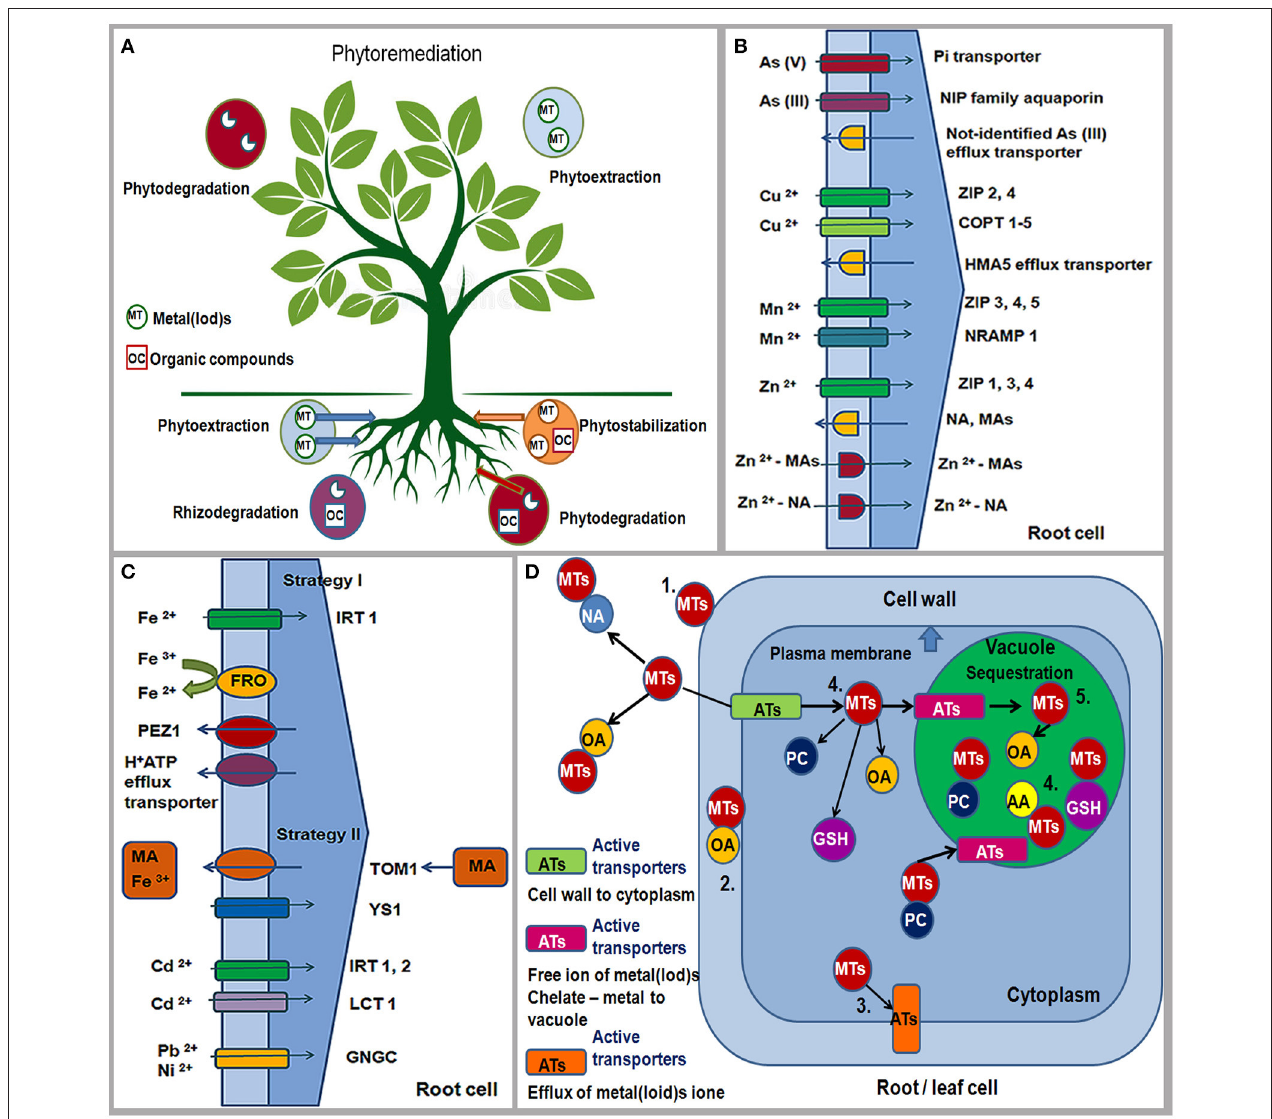
FIGURE 3 | Phytoremediation technologies: Phytostabilization; Phytoextraction; Phytostimulation/Rhizodegradation; Phytodegradation/Phytotransformation. MT, metal(loid)s; OC, organic compounds. Pollutants can be stabilized or degraded in the rhizosphere, sequestered or degraded in plant roots and leaves (schema modified from Pilon-Smits and LeDuc, 2009) (A) . Strategies for As, Cu, Zn, Mn, Fe, Cd, Ni and Pb uptake by plant roots from soil through different active transporters (ATs); ZIP/IRT, zinc, iron regulated protein; COPT, copper putative transporter; NRAMP, natural resistance –associated macrophage protein; HMA-heavy metal P-type ATPase; H + ATP, HA-proton efflux transporter; FRO-ferric reductase/oxidase; PEZ1, phenolics efflux zero1; TOM1, efflux transporter; YS1, yellow stripe-like1; NA, nicotinamine; MA, family of mugineic acids; LCT1, low-affinity cation transporter; GNGC channels, putative transition metal transporter (schema modified from Hall and Williams, 2003; Clemens, 2006) (B,C) ; Tolerance mechanisms for metal(loid)s in plants: (1) binding of metal(loid)s to the cell wall, (2) chelate of metal-organic acid on the outside of the cell membrane, (3) active metal efflux from cells, (4) metal-chelator complexes (5) compartmentalization or sequestration in a vacuole; Ats, active transporters; MTs, metal(loids); OA, organic acid; NA, nicotinamine; AA, amino acids; GSH, glutathione; PC, phytochelatines (schema modified from Tong et al., 2004; Pilon-Smits and LeDuc, 2009) (D)